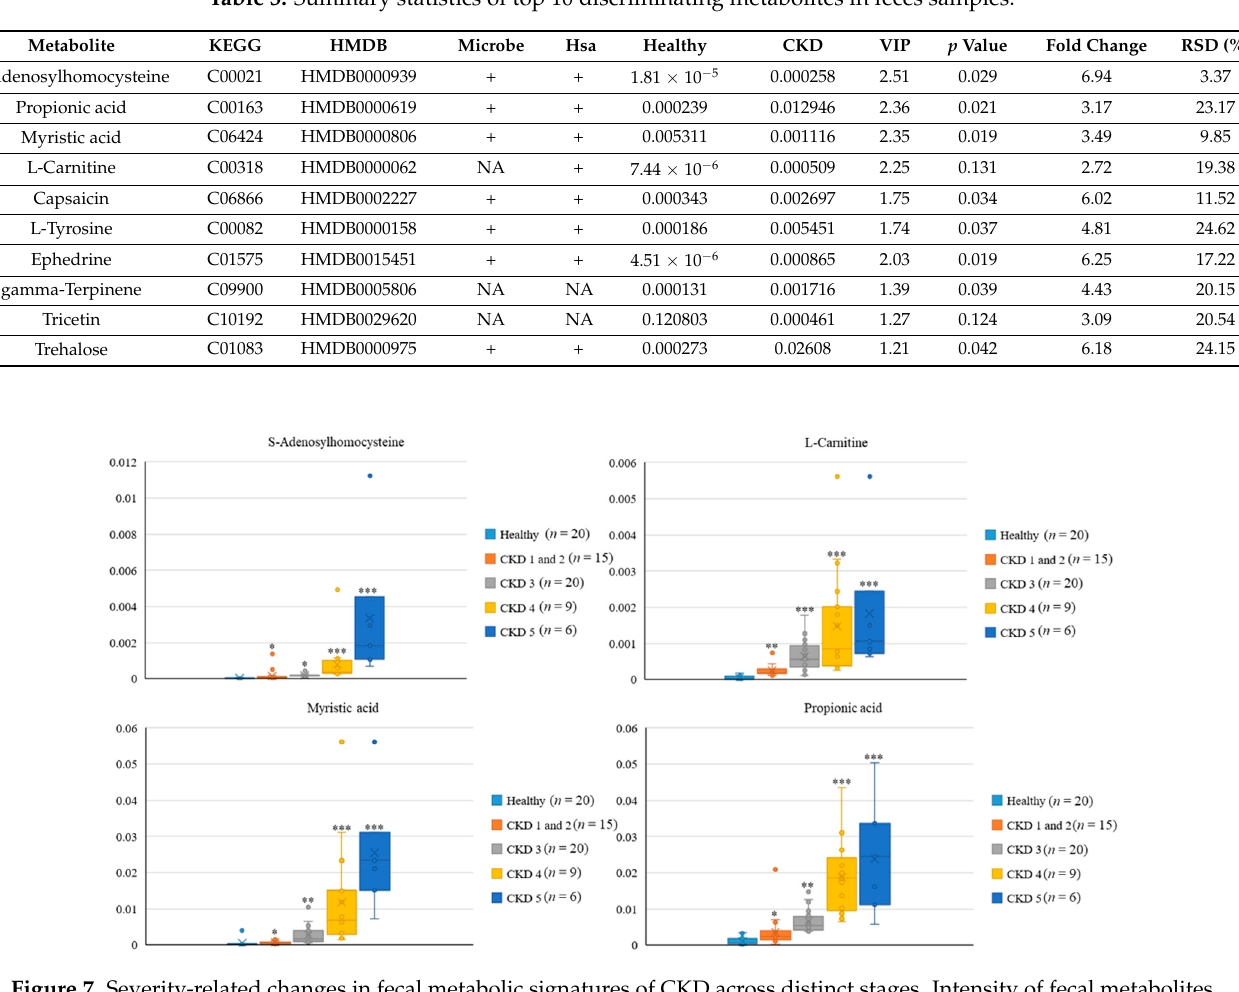
Figure 7. Severity-related changes in fecal metabolic signatures of CKD across distinct stages. Intensity of fecal metabolites among different groups were analyzed by Wilcoxon rank sum test. *** p < 0.001; ** p < 0.005; * p < 0.01.